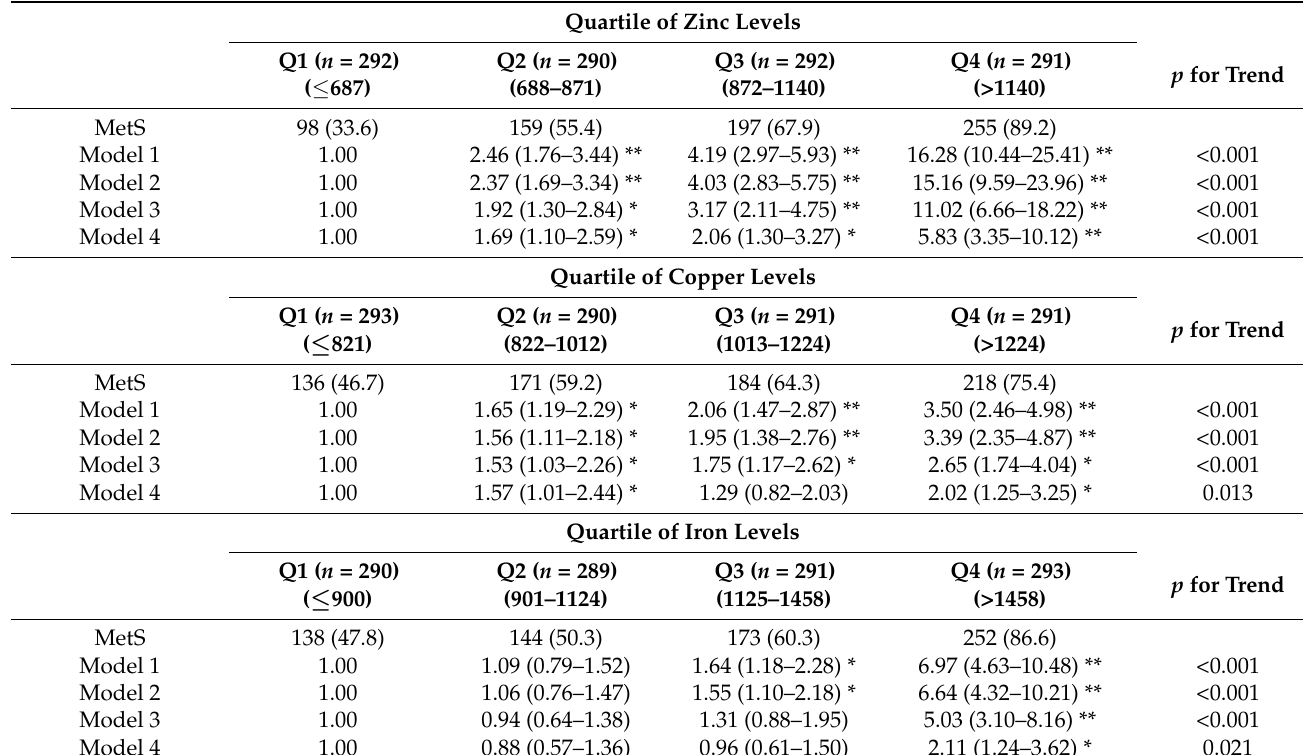
Table 2. Odds ratios of having MetS derived from multivariate logistic regression analyses in quartiles of serum zinc, copper, and iron